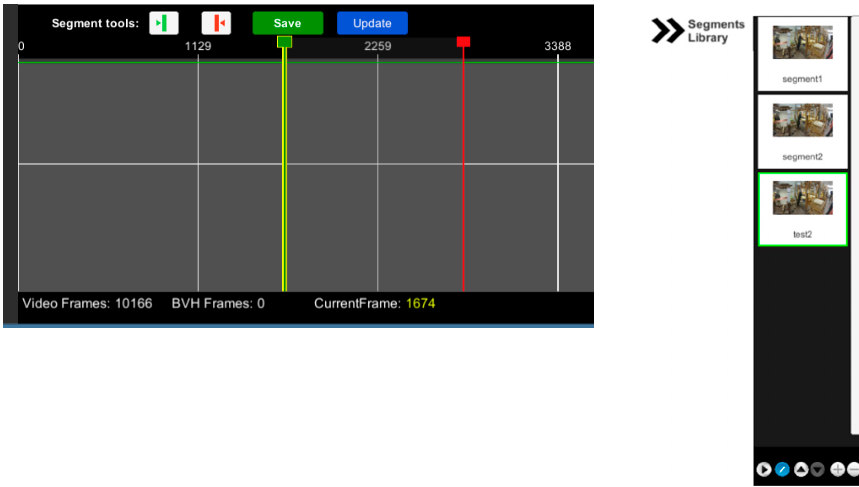
Figure 5. ( Left ): Timeline segment and controls. ( Right ): Segments library.